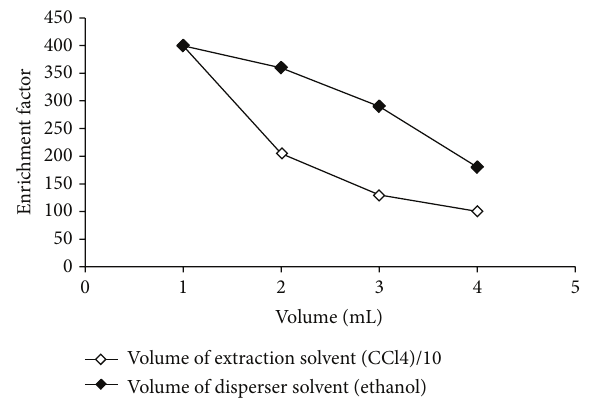
Figure 1: Influence of volume of the extraction solvent (CCl 4 ) and dispersive solvent (ethanol) on the enrichment factor of Cr(VI) and Pb(II) at 40mL initial volume of water samples 0.25% APDC, pH 3.00, and 0.01mg/L